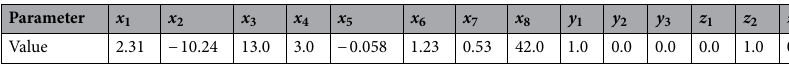
Table 2. Parameters of the concrete resistivity model.